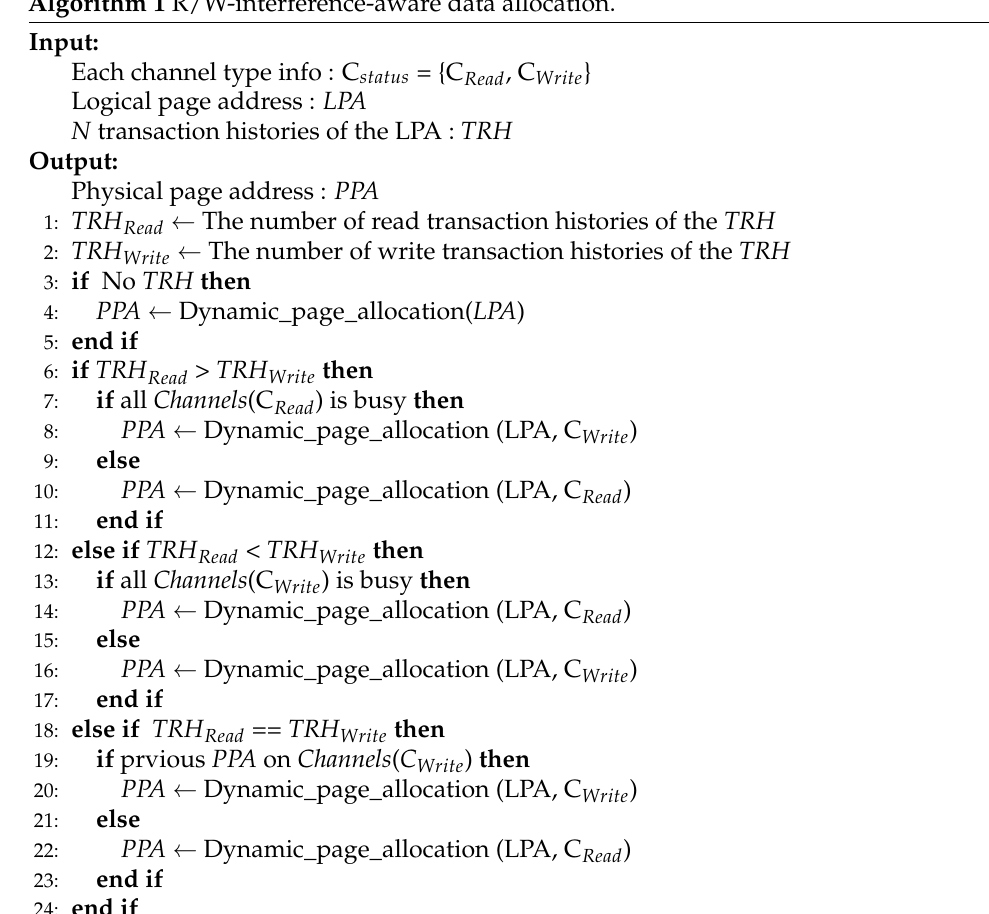
Algorithm 1 R/W-interference-aware data